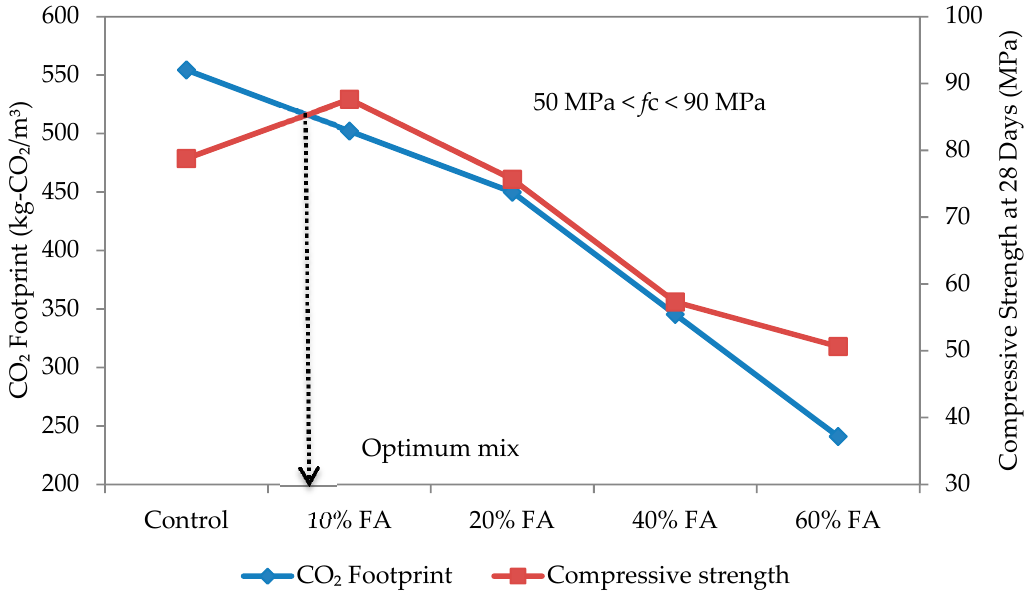
Figure 14. Optimum mix for self-compacting mortar at w/b 0.35.